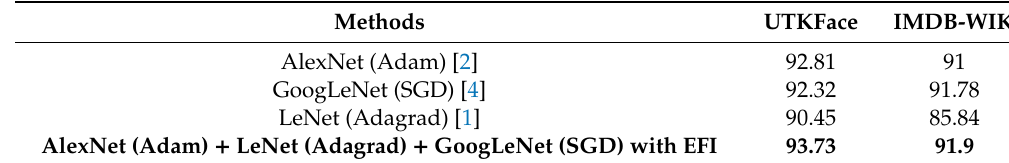
Table 15. Gender classification results in UTKFace and IMDB-WiKi databases.